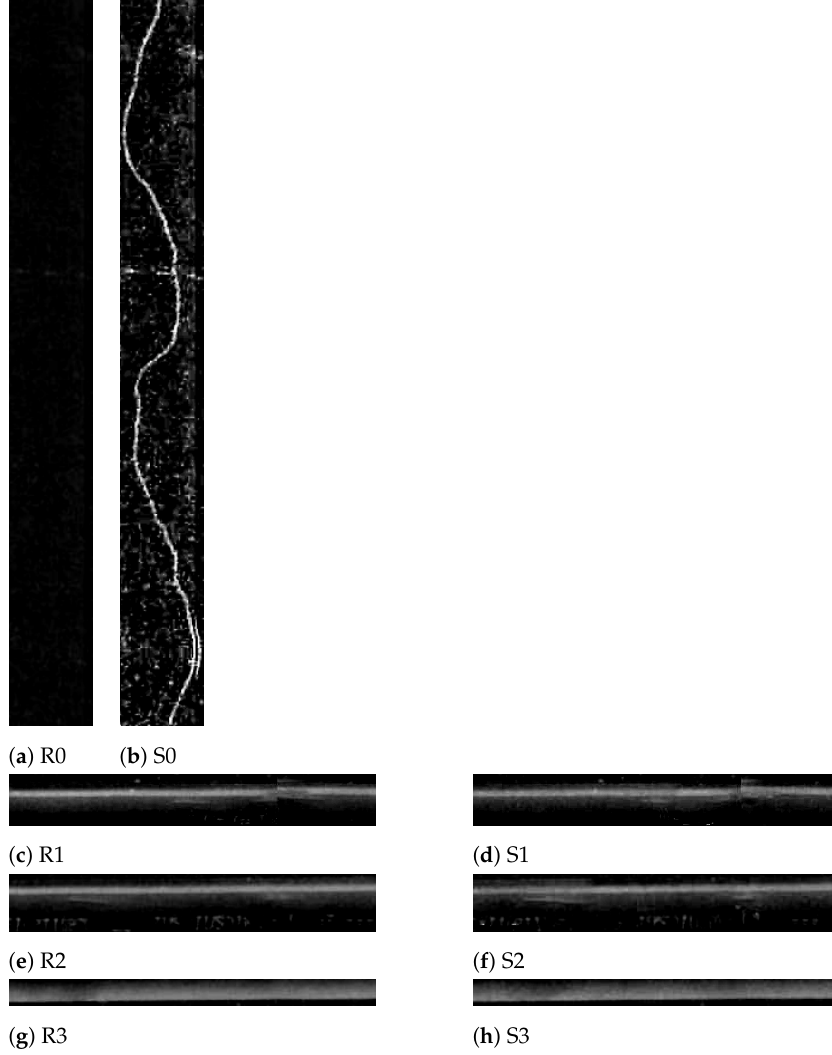
Figure 17. Change candidates ( a , b ) reference and survey patch ‘0’, ( c , d ) reference and survey patch ‘1’, ( e , f ) reference and survey patch ‘2’ and ( g , h ) reference and survey patch